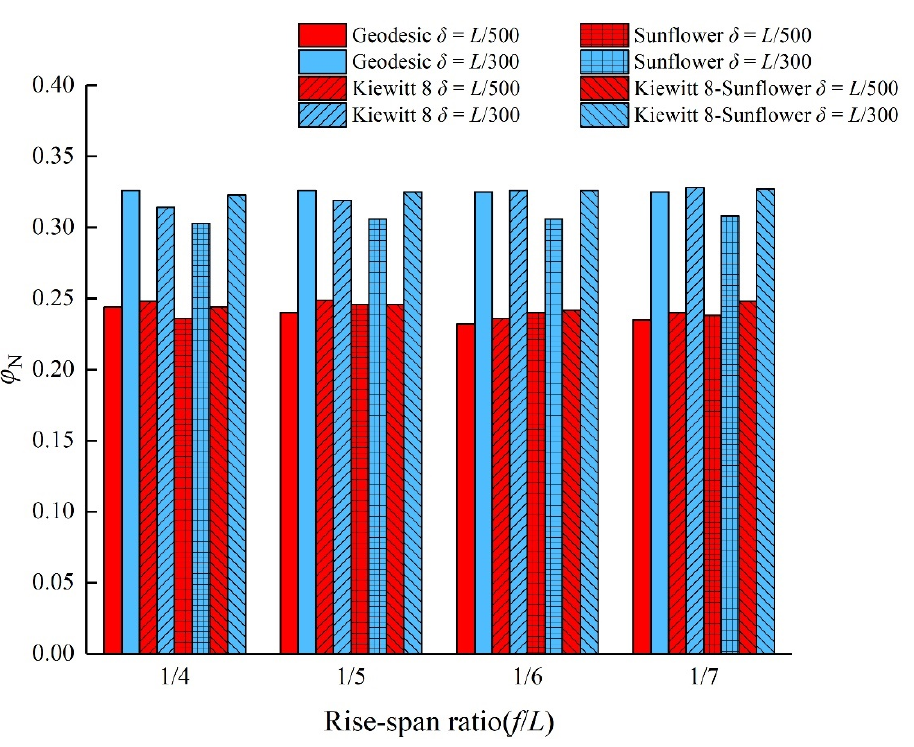
Figure 5. The average of RBA of MAS with L /300 and L /500.